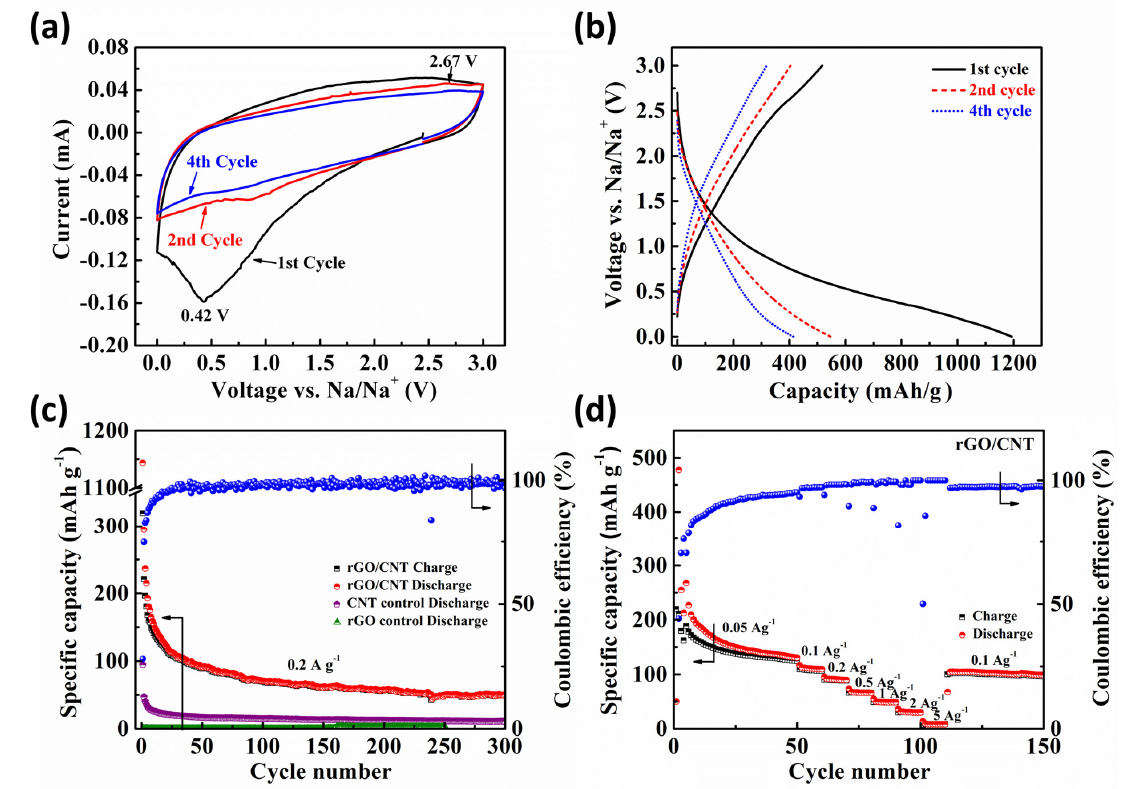
Figure 4. Electrochemical evaluation of free-standing rGO/CNT paper ( a ) Cyclic voltammograms in a voltage window from 0.001 to 3 V (vs. Na/Na + ) with a scanning rate of 0.1 mV s − 1 , ( b ) Discharge/charge curves in the 1st, 2nd and 4th cycles at 0.1 A g − 1 , ( c ) cycle test results of free-standing rGO/CNT paper as well as two control samples rGO and CNT at a current rate of 0.2 A g − 1 and ( d ) rate capability at various rates.